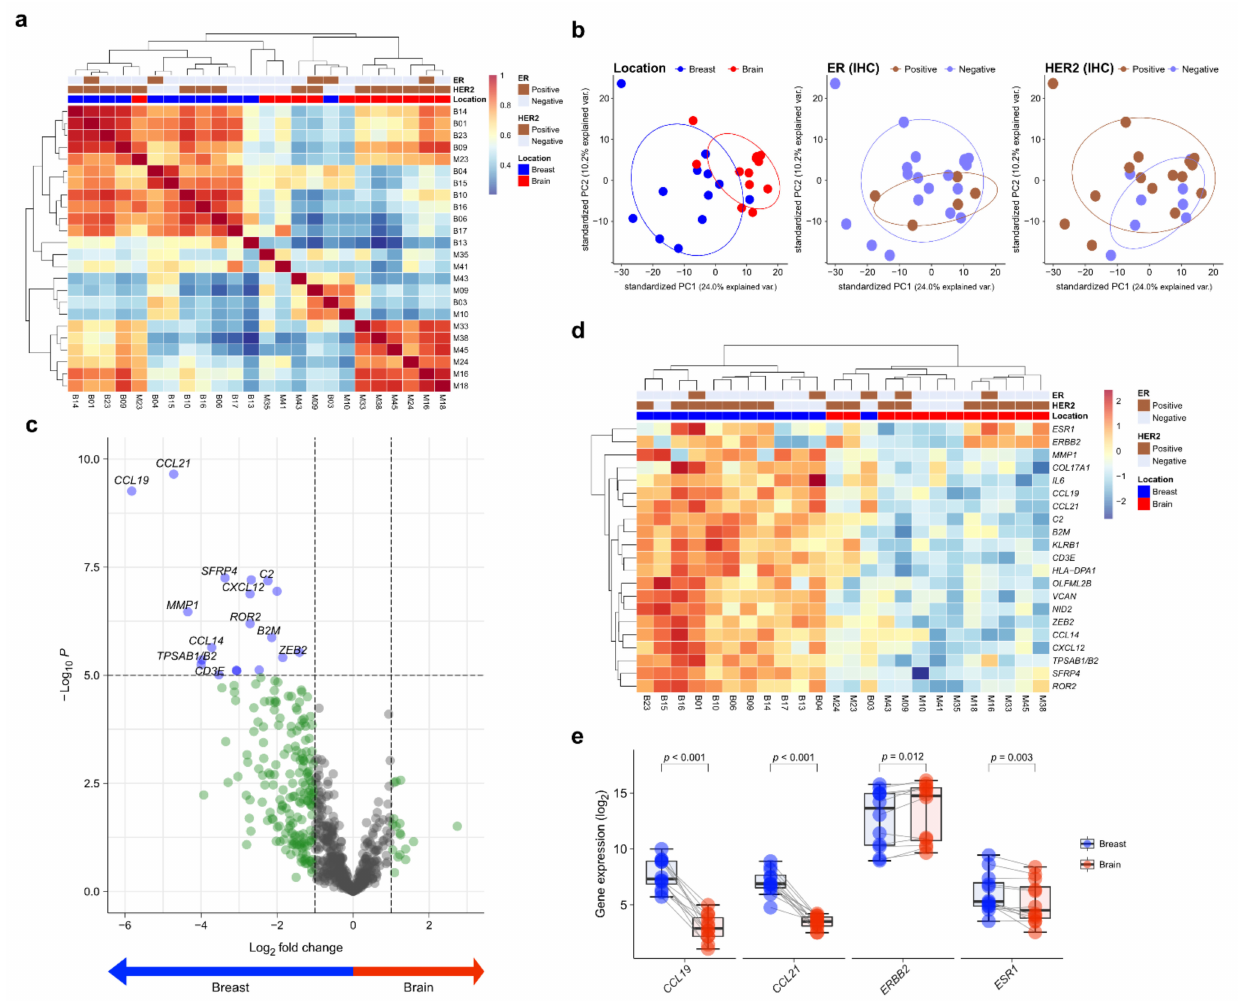
Figure 1. Differentially expressed genes (DEGs) in primary breast cancer and brain metastasis (BCBM) revealed by the nCounter ® IO360 TM Panel. ( a ) Correlation heatmap of unsupervised hierarchical clustering from 12 primary breast cancers and 12 matched brain metastases (BM) based on the gene expression profile. ( b ) Principal component analysis (PCA) plot of the 24 samples according to the involved location, estrogen receptor (ER) status, and human epidermal growth factor receptor 2 (HER2) status. ( c ) The volcano plot shows DEGs based on location with fold changes in expression >2 and p < 0.05. ( d ) Heatmap of representative genes showing differential expression profiles in primary BCBM. ( e ) Pairwise box plots of differential expression according to location showed that ESR1 , CCL19 , and CCL21 expression was higher in primary breast cancer, while that of ERBB2 was higher in